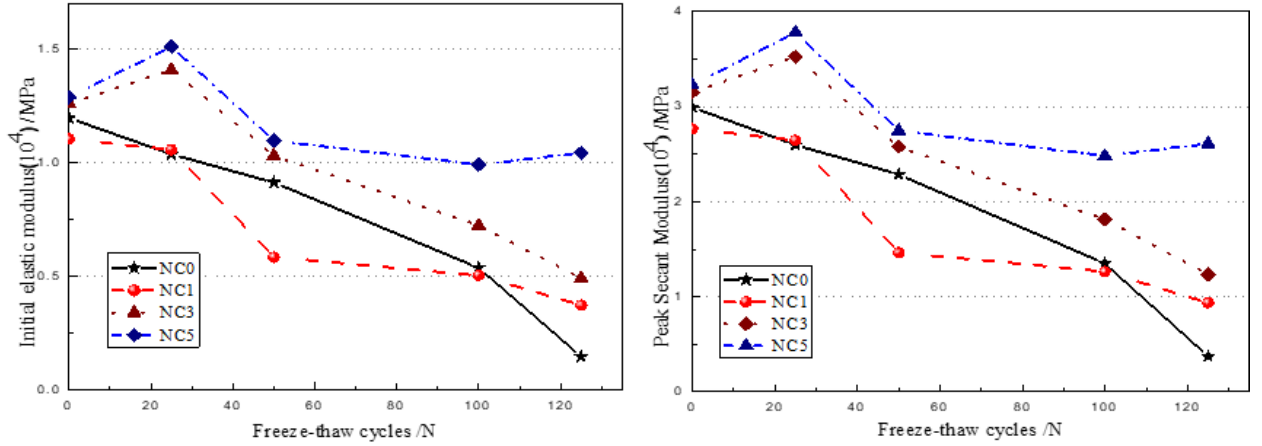
Figure 13. Initial modulus/peak secant modulus after freeze – thaw cycles. Li Yanlong et al. and Gong Xu et al. reveal that the peak stress decreases while the peak strain increases, the initial elastic modulus under compression decreases, and the stress – strain curve tends to be flat. Concrete after F – T damage increasingly exhibits more and more obvious brittle characteristics during the compression failure process.